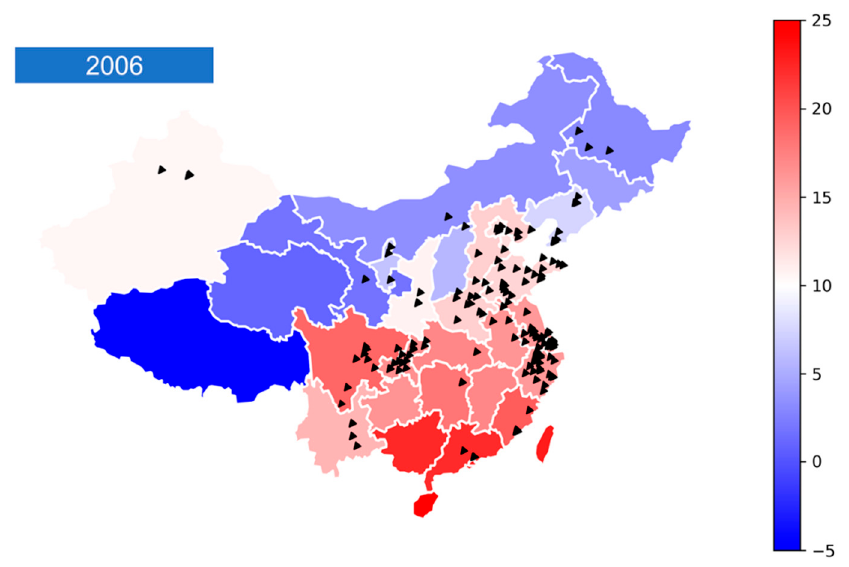
Figure A1. Annual average temperature levels in sample year (2006), and locations of wastewater treatment plants included in the sample.